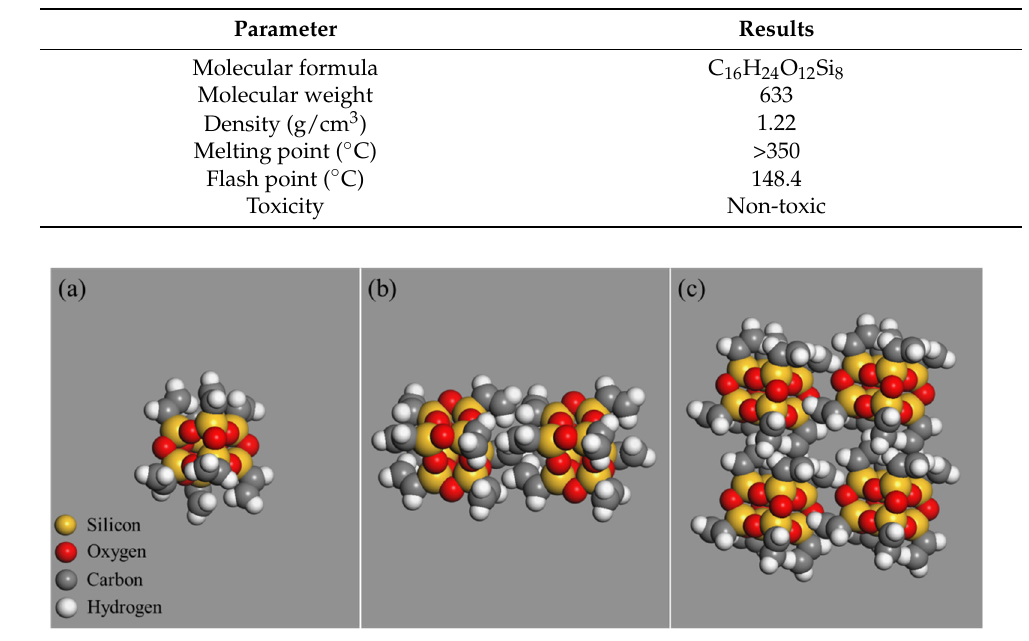
Table 4. The parameters of OvPOSS.